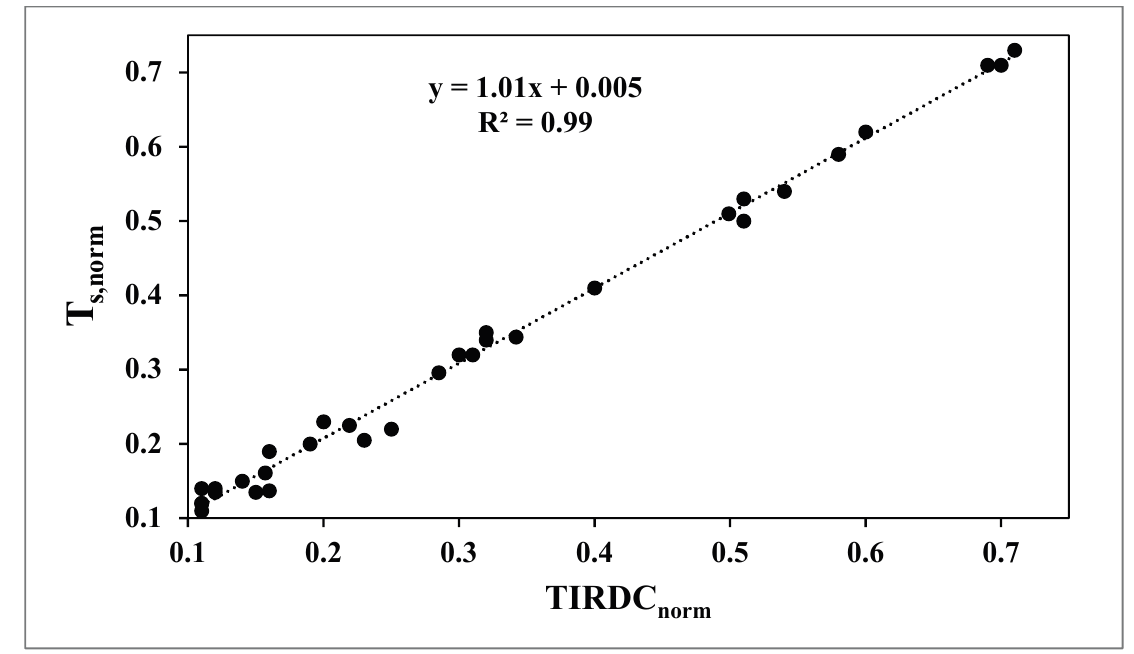
Figure 8. Simple linear regression between TIR norm and T s , norm for selected random